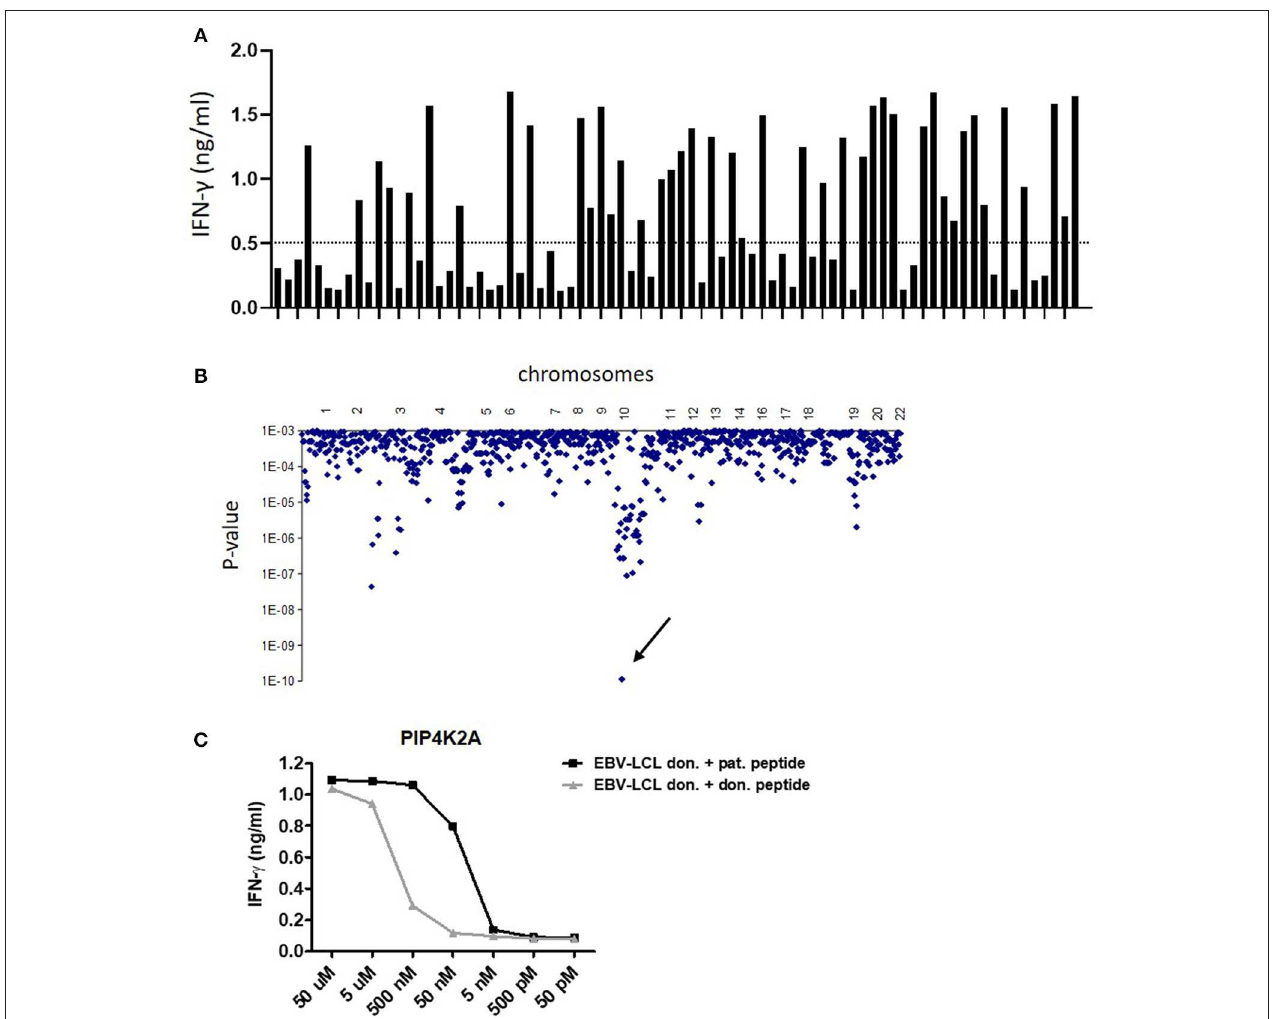
FIGURE 1 | Identification of LB-PIP4K2A-1S as new HLA class II-restricted minor histocompatibility antigen by whole genome association scanning. (A) T-cell recognition of a panel of 80 HLA-DRB1 * 0301 transduced EBV-LCL. Bars represent the level of IFN- γ (ng/ml) in ELISA released by clone 100 upon co-incubation with the different EBV-LCL. (B) Whole genome association scanning of the recognition data for 80 HLA-DRB1 * 0301 transduced EBV-LCL and the corresponding SNP data revealed one strongly correlating missense SNP in PIP4K2A (rs10828317) (arrow). The y -axis indicates P- values for the significance of association between SNPs and T-cell recognition of EBV-LCL. The x -axis represents the 1 million tested SNPs as distributed over the human chromosomes. (C) Synthetic peptides of patient and donor variants were loaded on donor EBV-LCL in indicated concentrations and recognition by T-cell clone 100 was measured in IFN- γ ELISA.